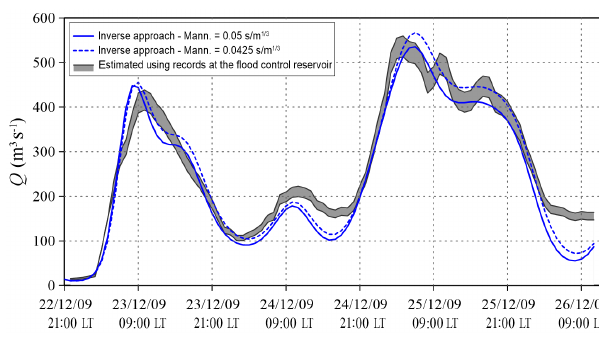
Figure 18. Secchia 2009 event: comparison among the inflow hy- drographs obtained from the inverse procedure using two different Manning coefficients and the envelope of different solutions ob- tained using the records at the flood control